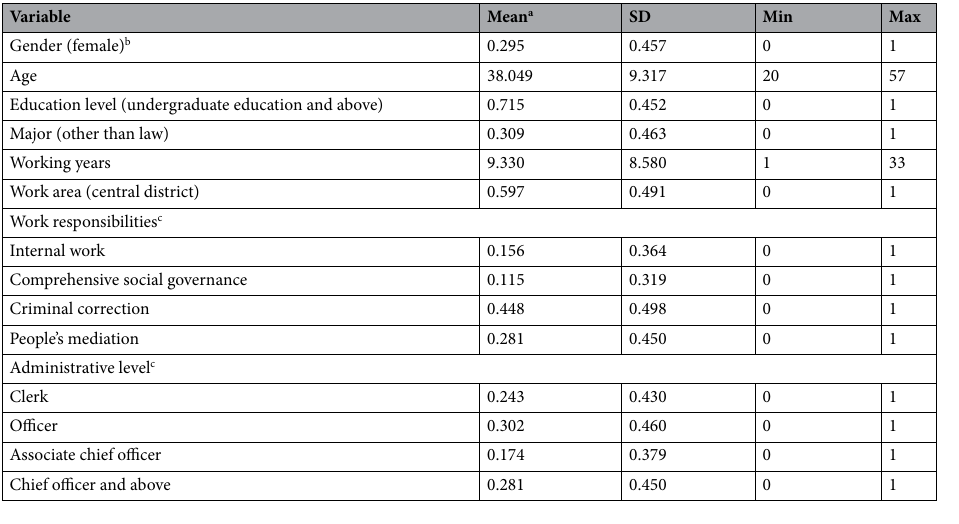
Table 1. Status quo of the grassroots judicial administrators. a. The mean of dichotomous variable indicates the percentage of category assigned with higher value, such as “1” = “female” and “0” = “male”, and the mean of gender = . 295, indicating that women account for 29.5%; b. the category in parentheses is assigned “1”; c. the work responsibilities and administrative levels have undergone dummy variable conversions from four-choice category variables to four dichotomous variables with values of